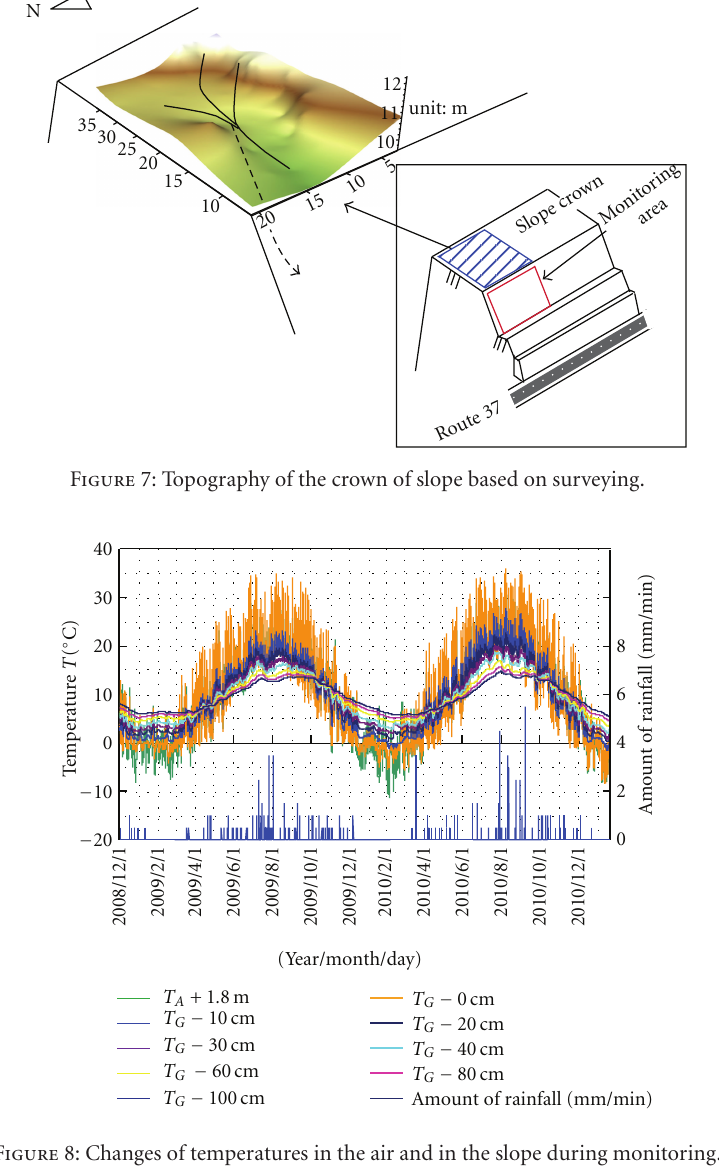
Figure 8: Changes of temperatures in the air and in the slope during